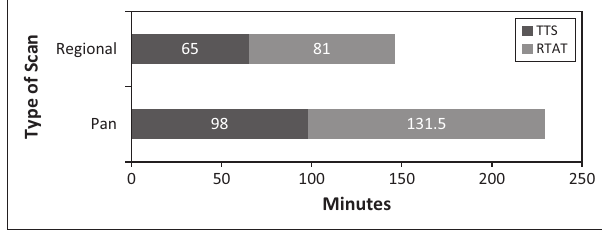
FIGURE 3: Time to scan (TTS) and report turnaround time (RTAT) in regional and pan scan patients.